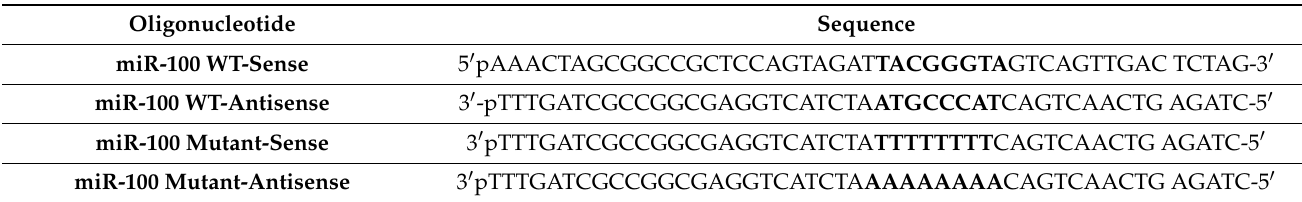
Table 1. Oligonucleotide sequences for